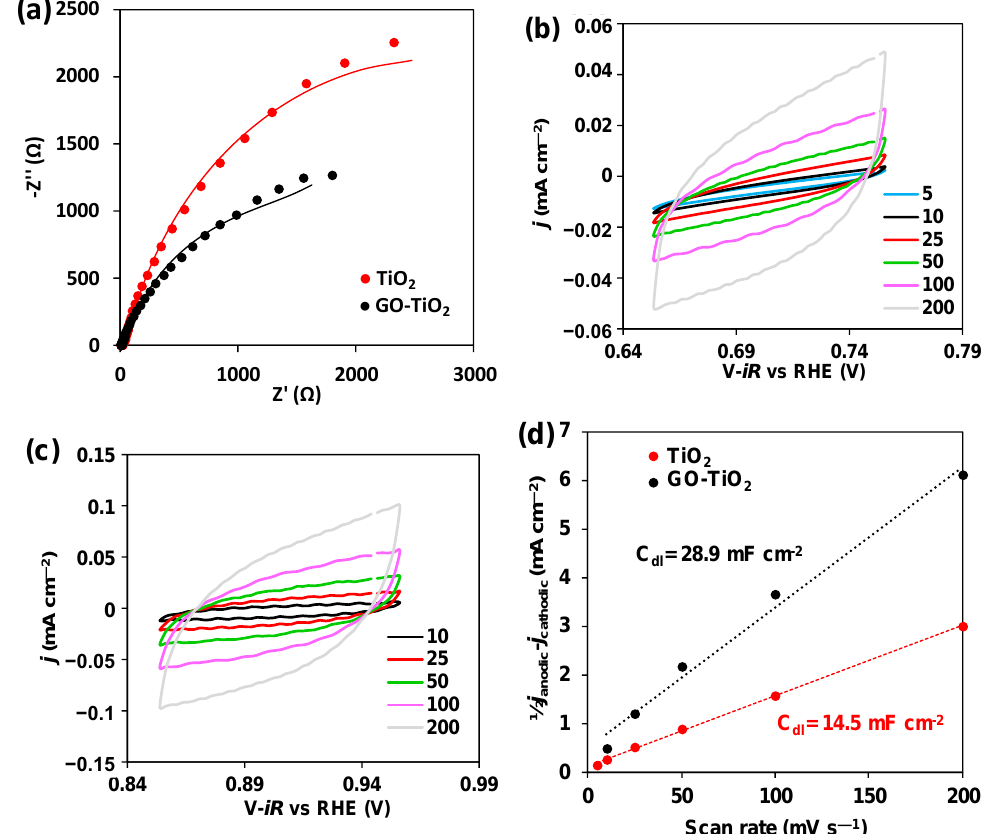
Figure 5. Electrochemical measurements: ( a ) Nyquist graph, where the lines represent the equivalent circuit adjustment; ( b , c ) are CVs at different scan rates (in mV s − 1 ) for TiO 2 ( b ) and TiO 2 -GO ( c ). CDL representation of both samples ( d